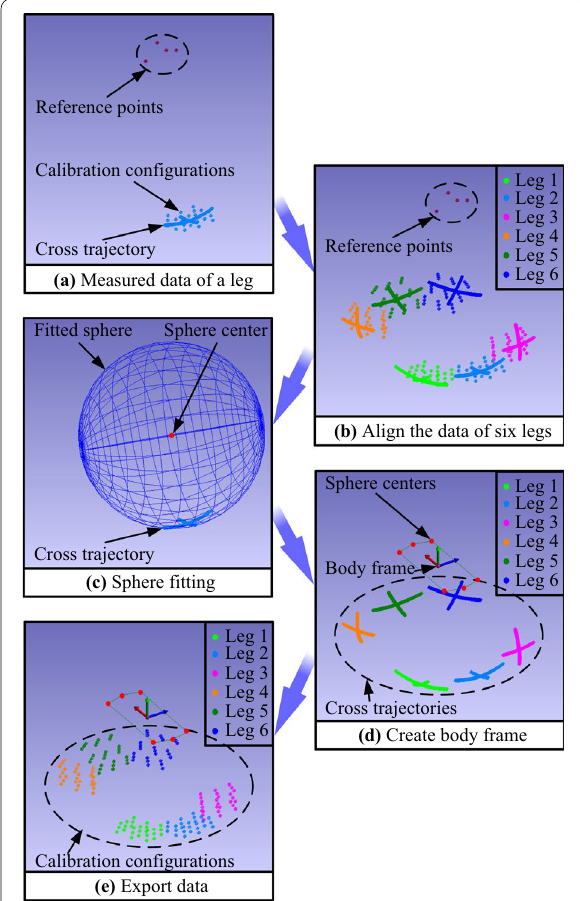
Figure 9 DAQ and preprocessing of the six-legged robot in the DAQ